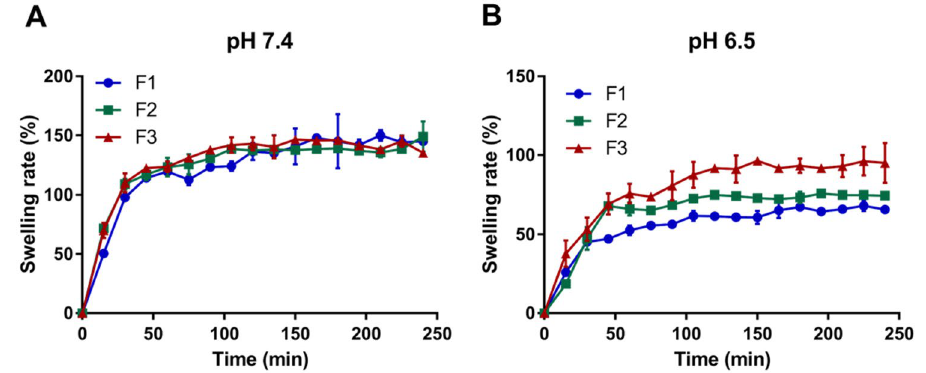
Figure 4. Low pH value notably decreases the swelling rates in PBS at 37 °C. The swelling rates of calcium alginate microcarriers after PBS immersion from 0 to 240 min were measured. ( A ) In pH 7.4 PBS, the maximal swelling rates were reached at 240 min for F1 (145.13% ± 1.237) and F2 (149.13% ± 12.904) while at 180 min for F3 (146.13% ± 1.590). ( B ) In pH 6.5 PBS, the maximal swelling rates were reached at 240 min for F1